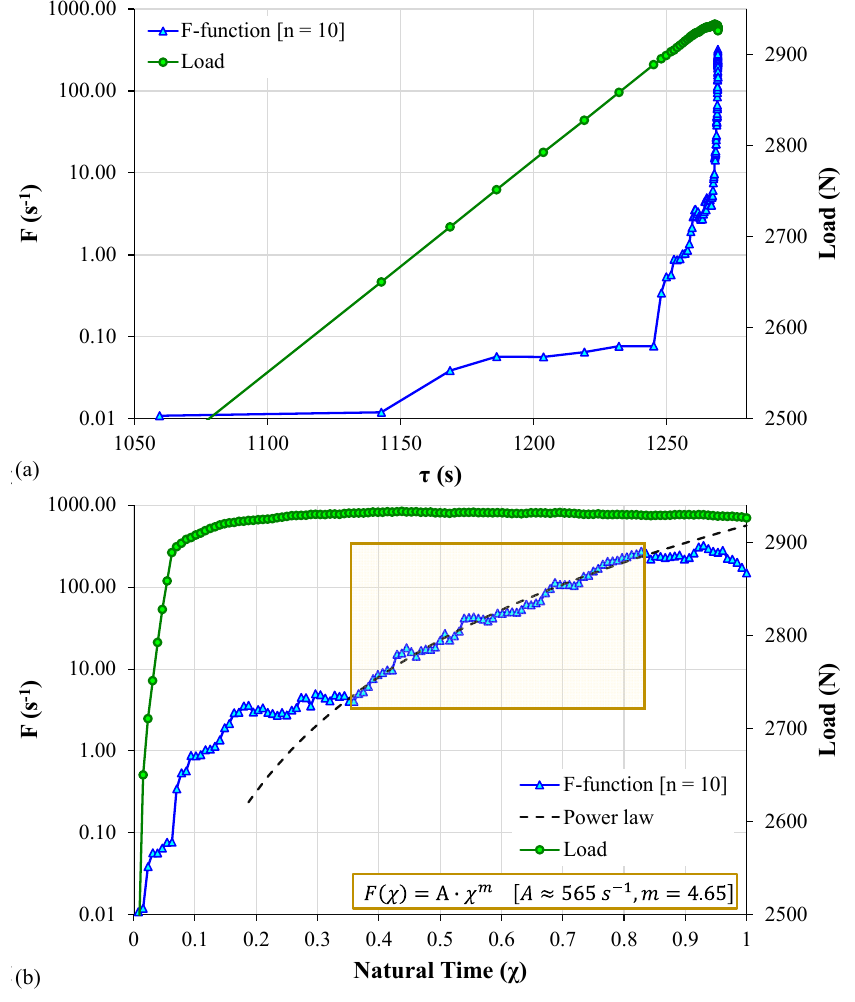
Figure 3. ( a ) The temporal evolution of the F -function and the load imposed. ( b ) The respective evolution in the Natural Time domain for the DENT marble specimen.